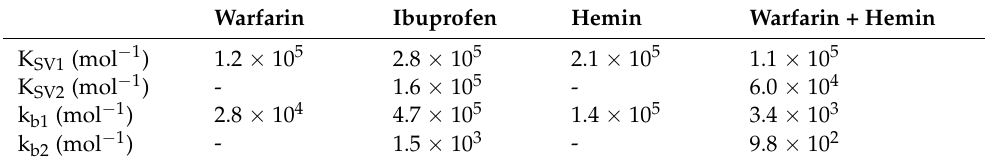
Figure 7. Corrected fluorescence spectra of HSA–warfarin ( A ), HSA–ibuprofen ( B ), HSA–hemin ( C ), and HSA–warfarin–hemin ( D ), systems in absence and presence of indomethacin at λ ex of 295 nm at 25 °C. [HSA] = 3 µM and [indomethacin] = 0. 1.0, 2.0, 3.0, 4.0, 5.0, 6.0, 7.0, 8.0, 9.0, and 10.0 µM. Table 3. Stern–Volmer quenching constants and binding constants obtained from the corrected fluorescence data of HSA–indomethacin interaction at 25 ◦ C in the presence of various site markers.